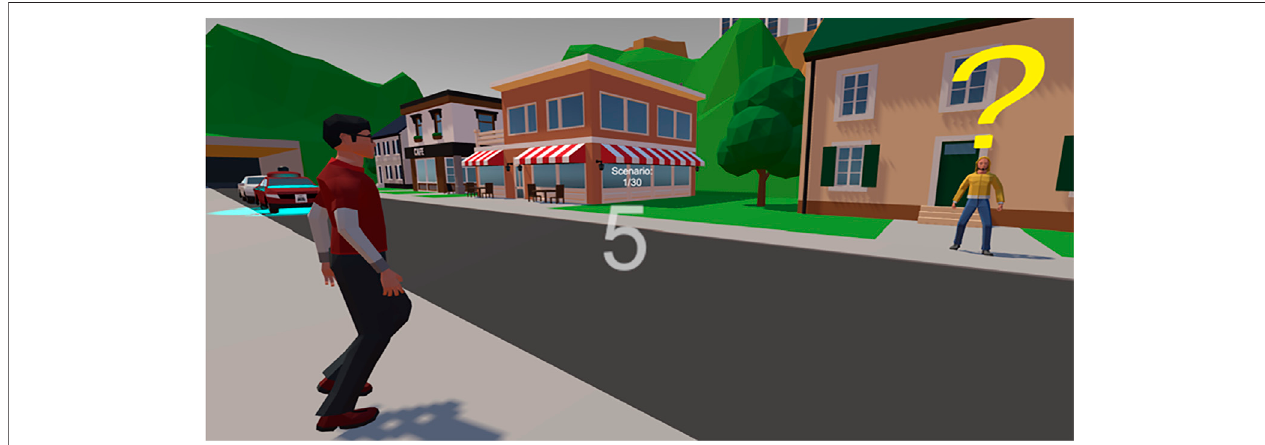
FIGURE2| Virtualreality “ street-crossinggame ” (participantperspective).Note:theparticipantisgiventhetaskofdeliveringpizzatoanon-playercharacteracross theroad.Ontheleftsideoftheparticipant,anon-playercharacterattemptstocrosstheroad.AyieldingAVcanbespottedwithbluedecelerationlightcues.Thetimerin the middle indicates 5 s left to earn the extra tip from pizza delivery.